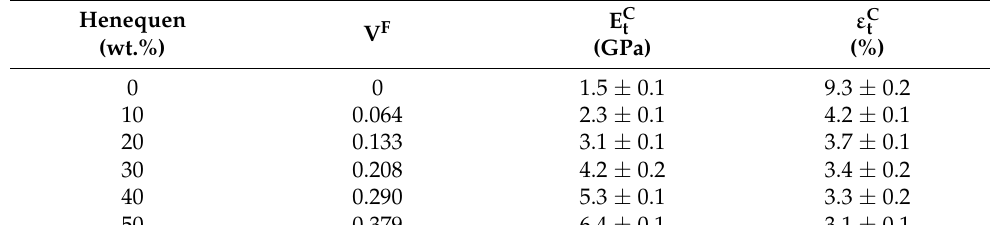
Table 1. Volume fraction of fibers into the composite (V F ), Young’s modulus (E C t ), and elongation at maximum stress ( ε C t ) of PP-based composites reinforced with 10–50 wt.% of henequen fibers containing a 4 wt.% of MAPP.